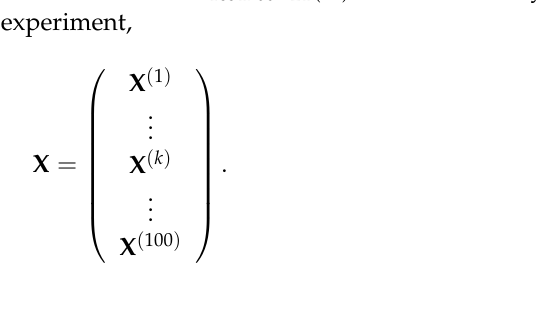
Table 1. Total number of experimental tests for the different white noise (WN) amplitudes and for each structural